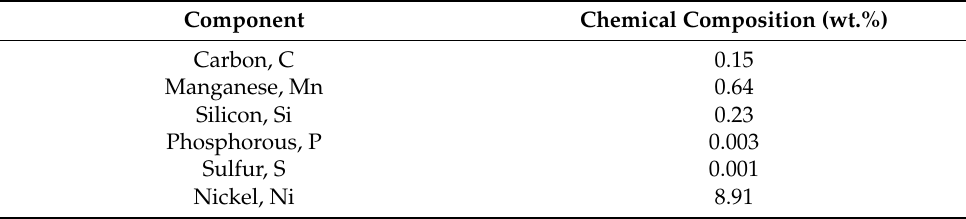
Table 1. Chemical composition of 9% nickel steel.